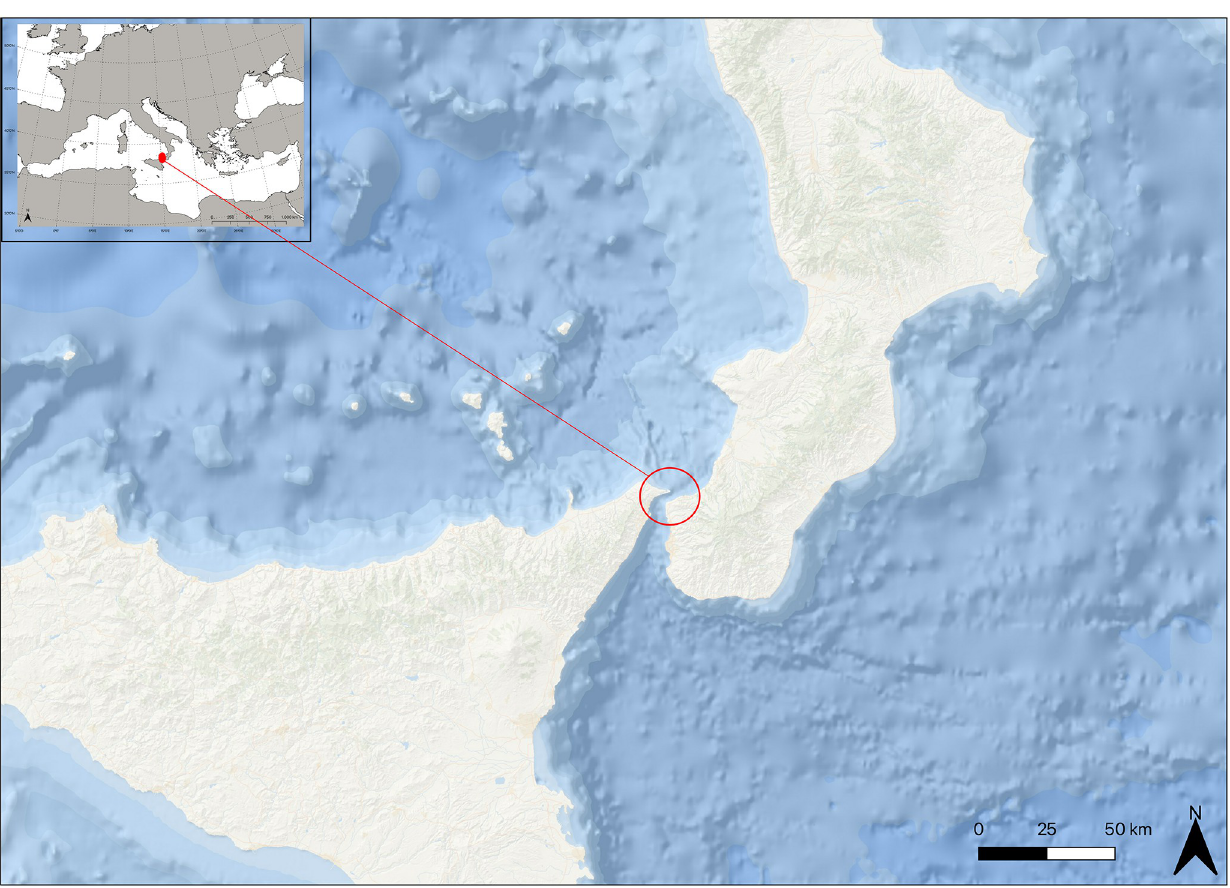
Fig 1. Maps of the studied area with the Strait of Messina reported in the red circle and the Mediterranean Sea in the insert. Data source: QGIS Development Team. QGIS Geographic Information System (version 3.26). https://qgis.org/en/site/.